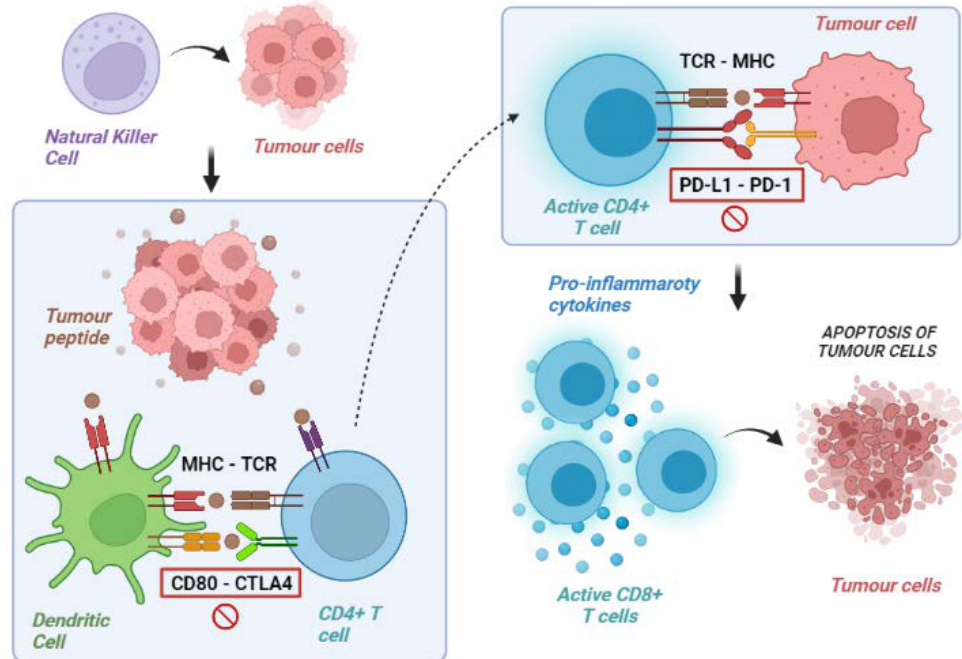
Figure 1. Exemplification of tumour immunity cycle. Natural killer and other cells of the immune system provoke lysis of tumour cells with liberation of tumour peptides. These peptides are exposed on surface molecules on dendritic and other antigen-presenting cells and are recognised by CD4 T lymphocytes (priming phase). These lymphocytes, therefore, acquire the ability to identify tumour cells and to promote a cytotoxic response via CD8 lymphocytes (effector phase). MHC: major histocompatibility complex; TCR: T-cell receptor; CD: cluster differentiation; CTLA-4: cytotoxic T lymphocyte-associated protein 4; PD-1: programmed death-1; PD-L1: programmed death 1-ligand.